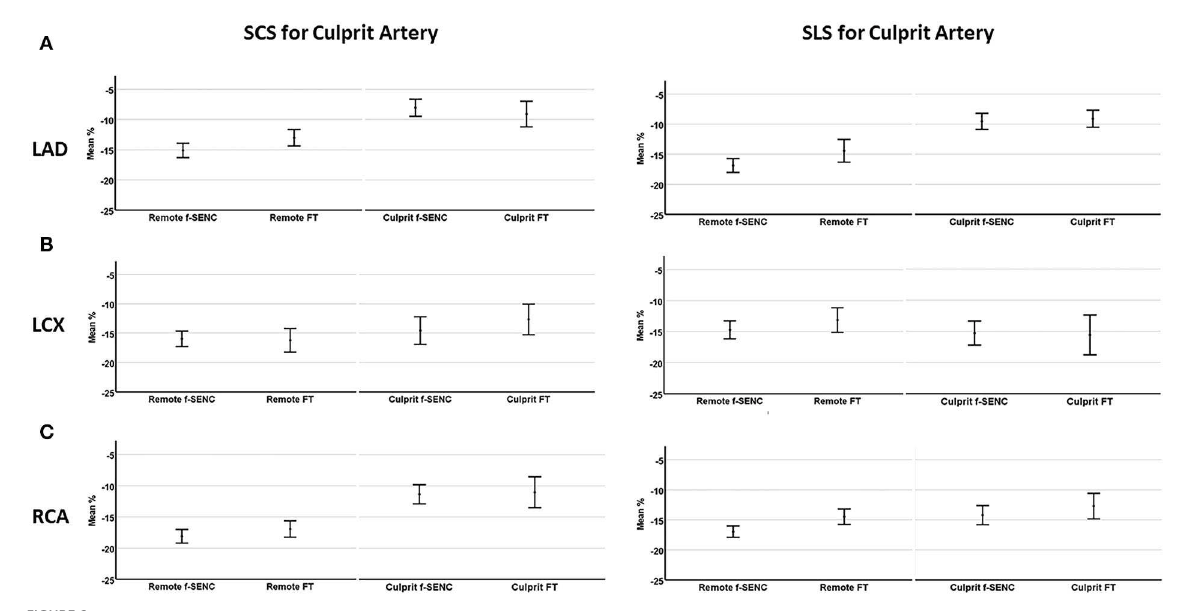
FIGURE6 Mean strain of culprit artery segments and remote myocardium for left anterior descending artery (A) , left circumflex artery (B) , and right coronary artery (C) . Segmental circumferential strain (SCS) and segmental longitudinal strain (SLS) are presented for each infarcted related